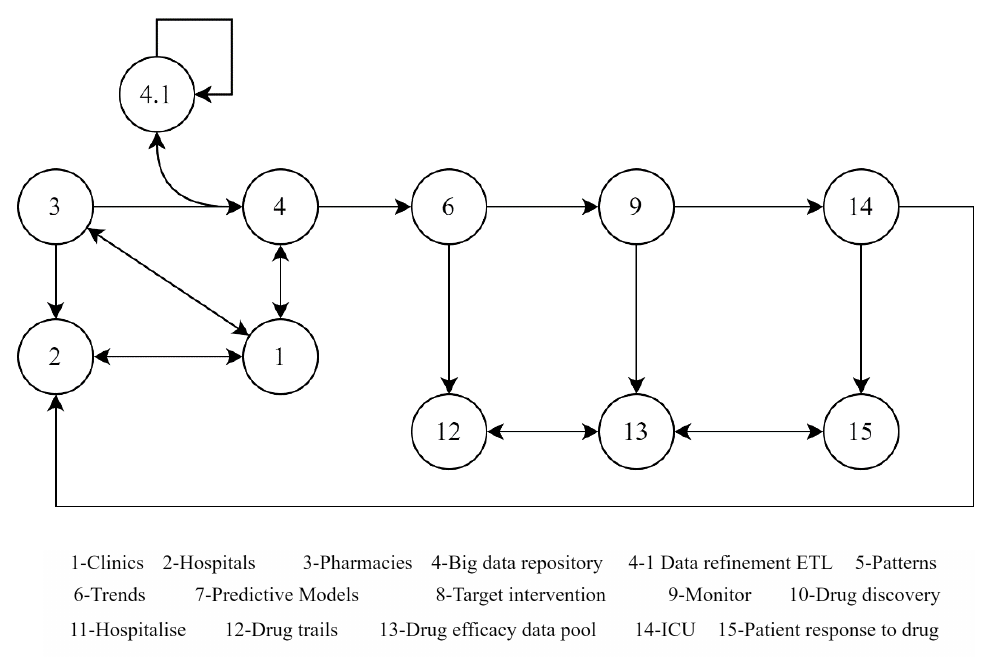
Figure 2. Flowchart for drug efficacy monitoring system using big